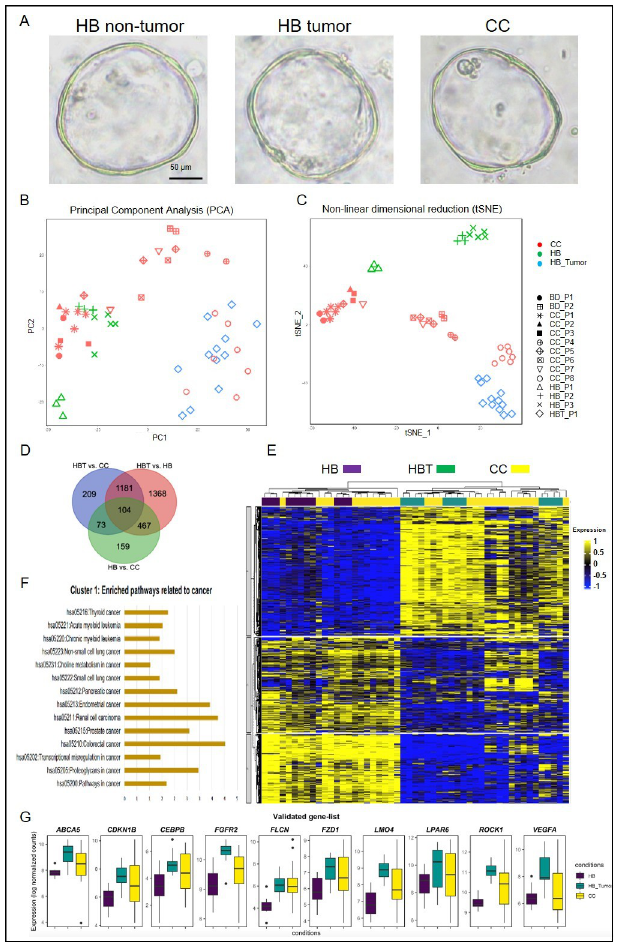
Fig 1. Expression levels for dysregulated cancer-related genes from patient derived organoids. (A) Pictures of P0 cholangiocyte organoids from hepatoblastoma (HB) non-tumor and tumor livers; choledochal cyst (CC) livers/bile ducts. (B) Principal Component Analysis (PCA) analysis showing first two PCs capturing highest variance, 69% (dimension 1: 60% + dimension 2: 9%) in expression data; each dot represents an organoid. (C) Non-linear dimensional reduction (TSNE) showing clustering of patient derived organoid. Each dot represents an organoid; CC, HB and HBT organoids were indicated with different colours; and different shapes indicated organoids from patient with I.D.. CC organoids clustering close with HBT organoids were enclosed with broken blue line. (D) Heatmap clustering shows total differentially expressed genes and grouping of CC samples with HB and HB-Tumour. (E) Significantly enriched cancer related pathways for DE genes from cluster 1, using KEGG pathway analysis. (F) Expression levels of the top 10 DE cancer-related genes in HB and CC organoids.